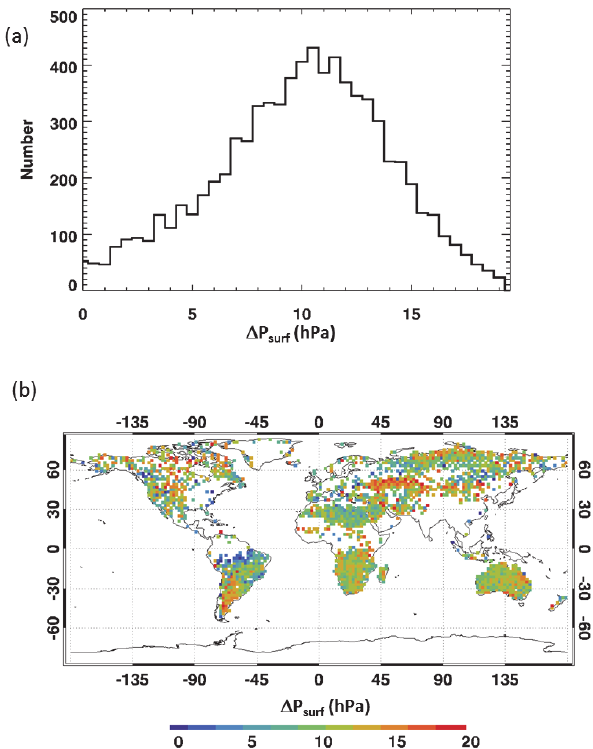
Fig. 2. (a) Histogram of differences between the retrieved surface pressures and the surface pressure prior estimated from ECMWF data, 1P surf (hPa), for all soundings over land in July 2009. (b) Map of differences between the retrieved surface pressure and the prior for July 2009.